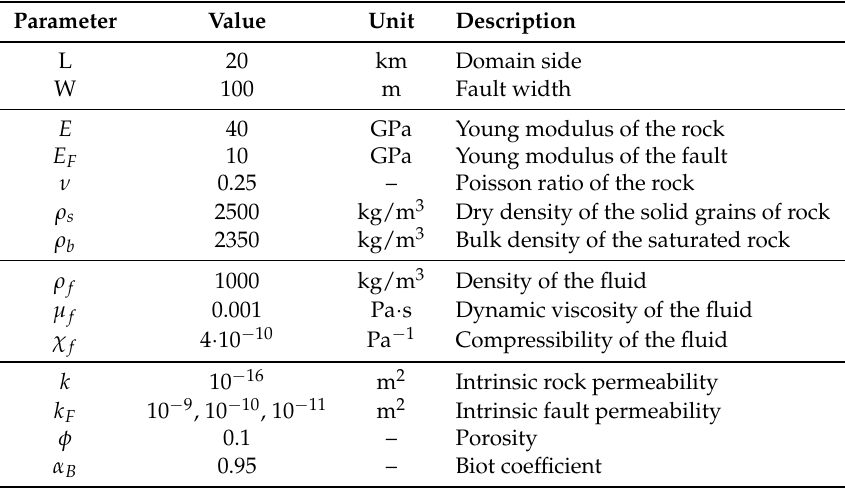
Table 3. Parameters of the three-dimensional (3D) models (Figures